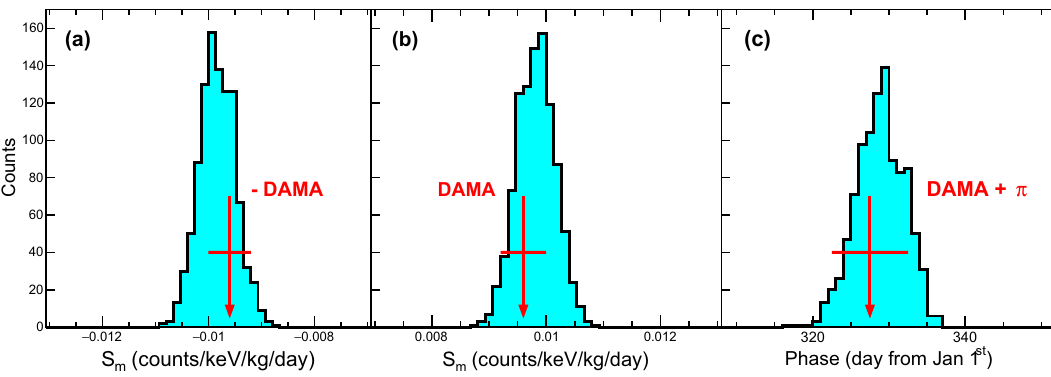
Figure 8. Results of 1000 simulated experiments for the DAMA/LIBRA experiment. We generate 1000 simulated experiments with a background derived from COSINE-100 with an exposure and analysis method derived from the DAMA/LIBRA experiment without the dark matter signals. ( a ) Results of the modulation amplitudes ( S m ) using the phase-fixed fit are presented with DAMA/LIBRA’s modulation amplitude. Although negative signs (opposite phase) are required, the simulated experiments obtain a modulation amplitude consistent with DAMA/LIBRA. Results for the phase-floated fits are shown for the modulation amplitude ( b ) and the modulation phase ( c ). Here we also observe consistent modulation amplitude but opposite phase by shifting the phase by π between the simulated experiments and